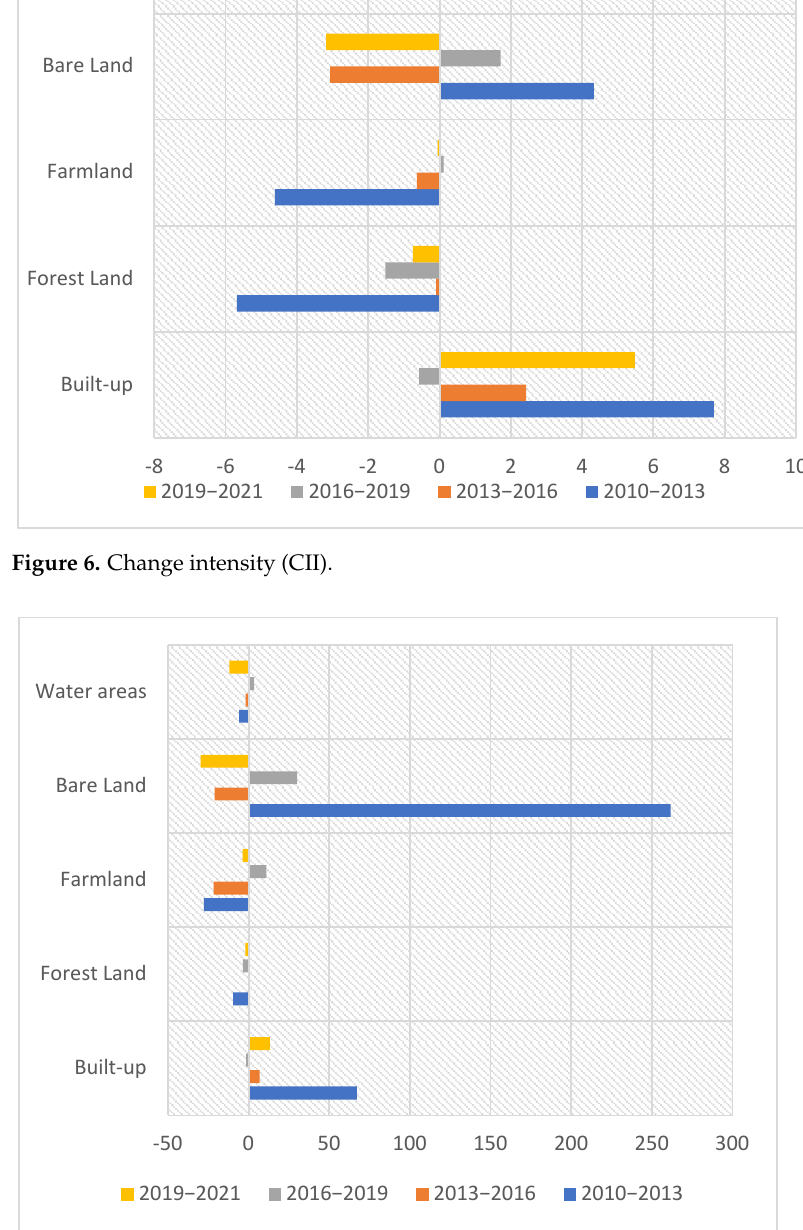
Figure 7. Rate of change (ARC).